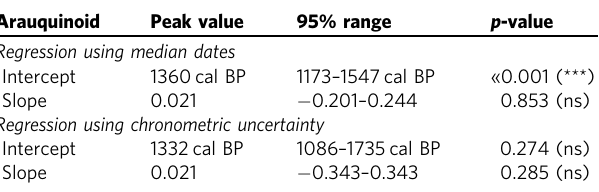
Table 2 Regression results for the arauquinoid